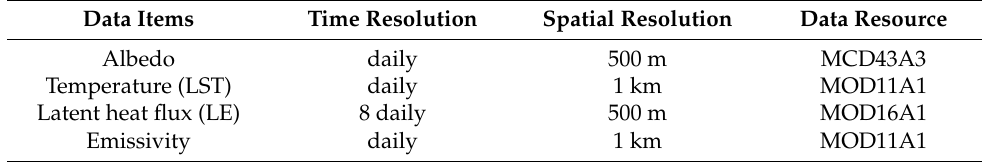
Table 1. Moderate Resolution Imaging Spectro radiometer (MODIS) data items and descriptions.